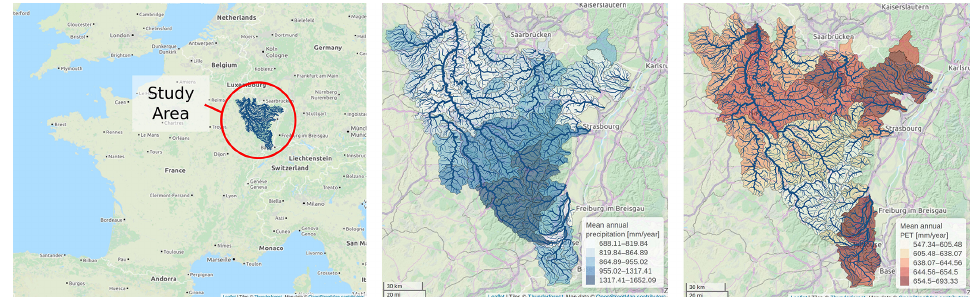
Figure 1. Location of the study area (left), and average annual precipitation (centre) and annual potential evapotranspiration (right) for each sub-catchment (climate data are estimated from the 1971–2000 SAFRAN database).